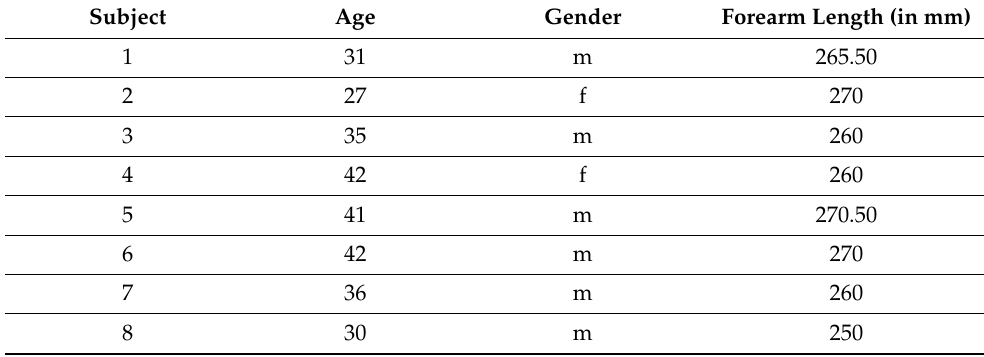
Table 1. This subject ‐ specific demographics and anatomic measures.